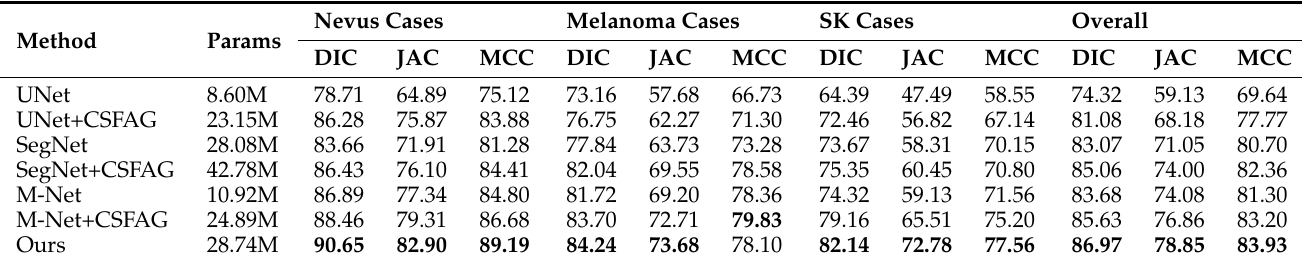
Table 8. The performance comparison of Jaccard coefficient, Dice coefficient and Matthew correlation coefficient of the three basic architecture networks and their new network structure with the CSAG and DCCNet (ours) model on the ISIC-2017 data set. Bold data indicates that the value is the maximum value in this